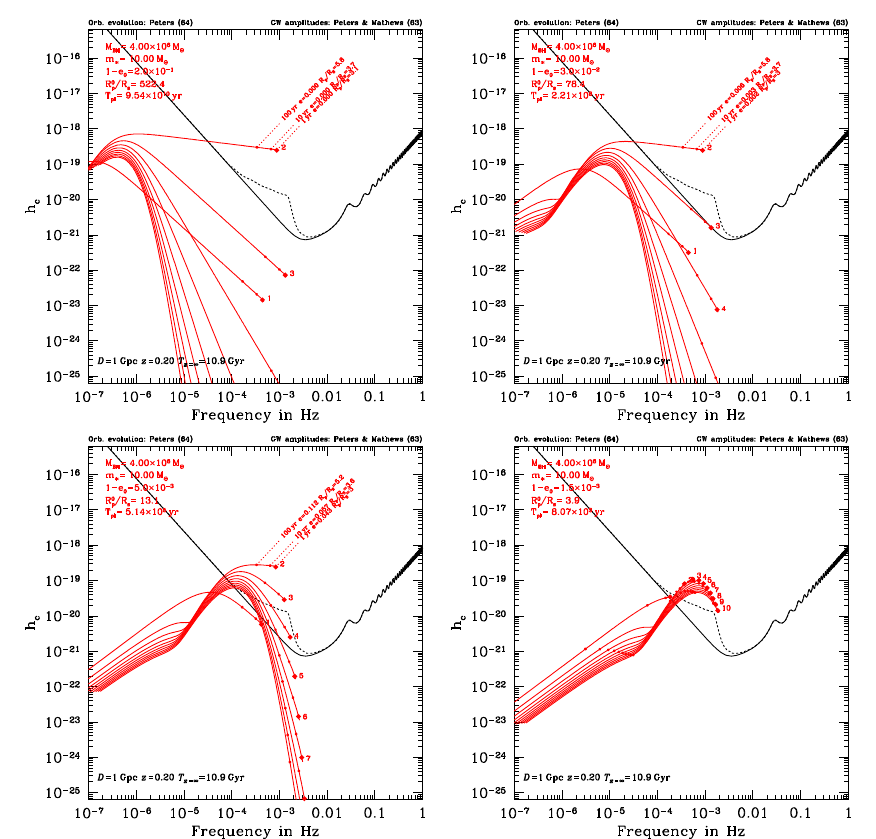
Fig. 41 Characteristic amplitude, introduced in Eq. (77), of the first harmonics of the quadrupolar grav- itational radiation emitted during the inspiral of a stellar-mass BH of m • = 10 M (cid:2) ( m ∗ in the plot) into a MBH of mass M • = 4 × 10 6 (M BH in the plot). I assume the source is at a distance D = 1Gpc. I (cid:11) f S h ( f ) for a LISA-like detector (Larson et al. 2000; Larson 2003), with the indicate the noise curve Galactic binary white dwarf confusion background in dashed line (Bender and Hils 1997). Note that the height of the point for the amplitude above the curve does not represent the SNR (see text). From the top to the bottom and from left to right, the panels represent a binary which starts at a semi-major axis of 10 − 3 pc and we change the eccentricity, e = 0 . 8 , 0 . 97 , 0 . 995 , 0 . 9985. Each panel shows the ratio R 0 p / R s , the initial periapsis distance over the Schwarzschild radius of the system. The first three panels display three moments in the evolution for which the time to coalescence in the is 100, 10 and 1 yr C EMRI = 1] assuming a constant value t rlx = 1Gyr. The lower dash-dotted